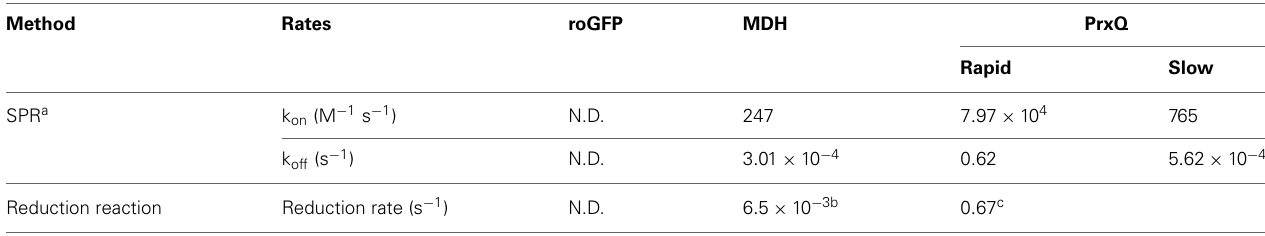
Table 1 | Rate constants of target proteins interacting with Trx h 1.